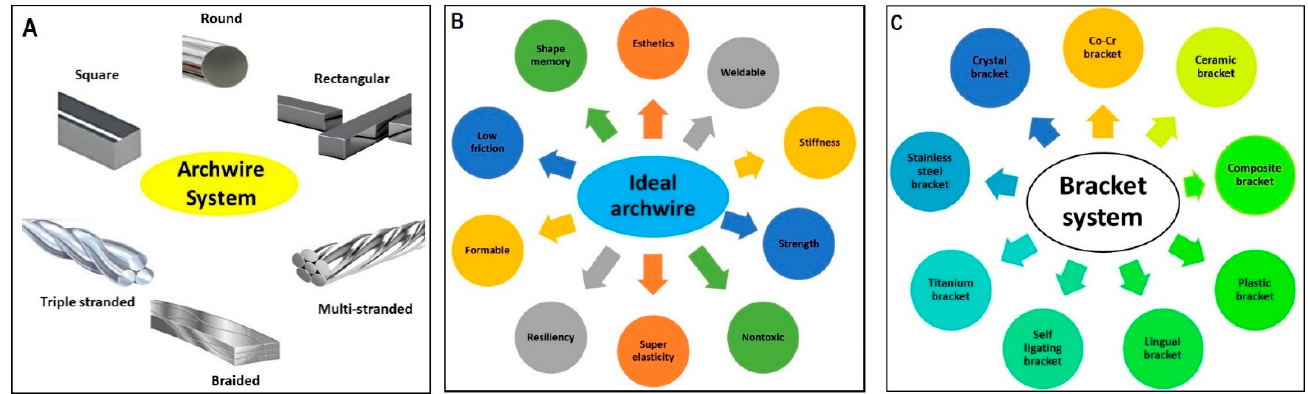
Figure 3. ( A ) Different archwire system being used for orthodontic treatment, ( B ) properties of the ideal archwire system, ( C ) different bracket system being applied for orthodontic treatment.